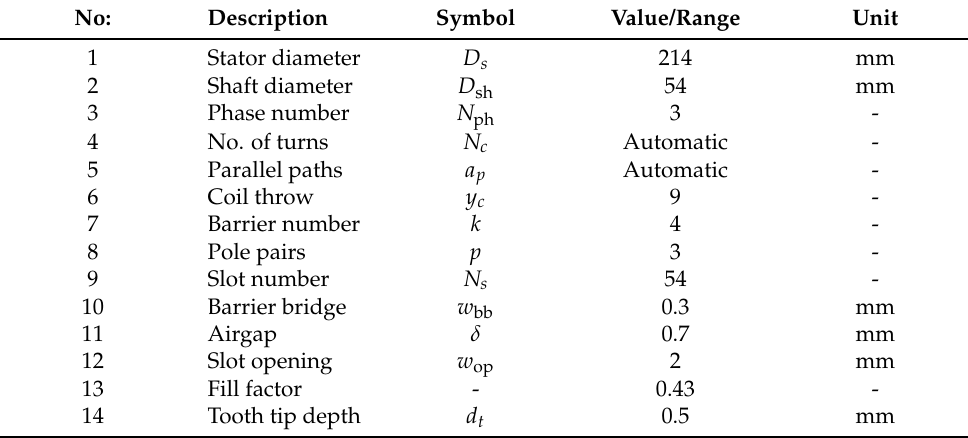
Table 3. List of constant design parameters.